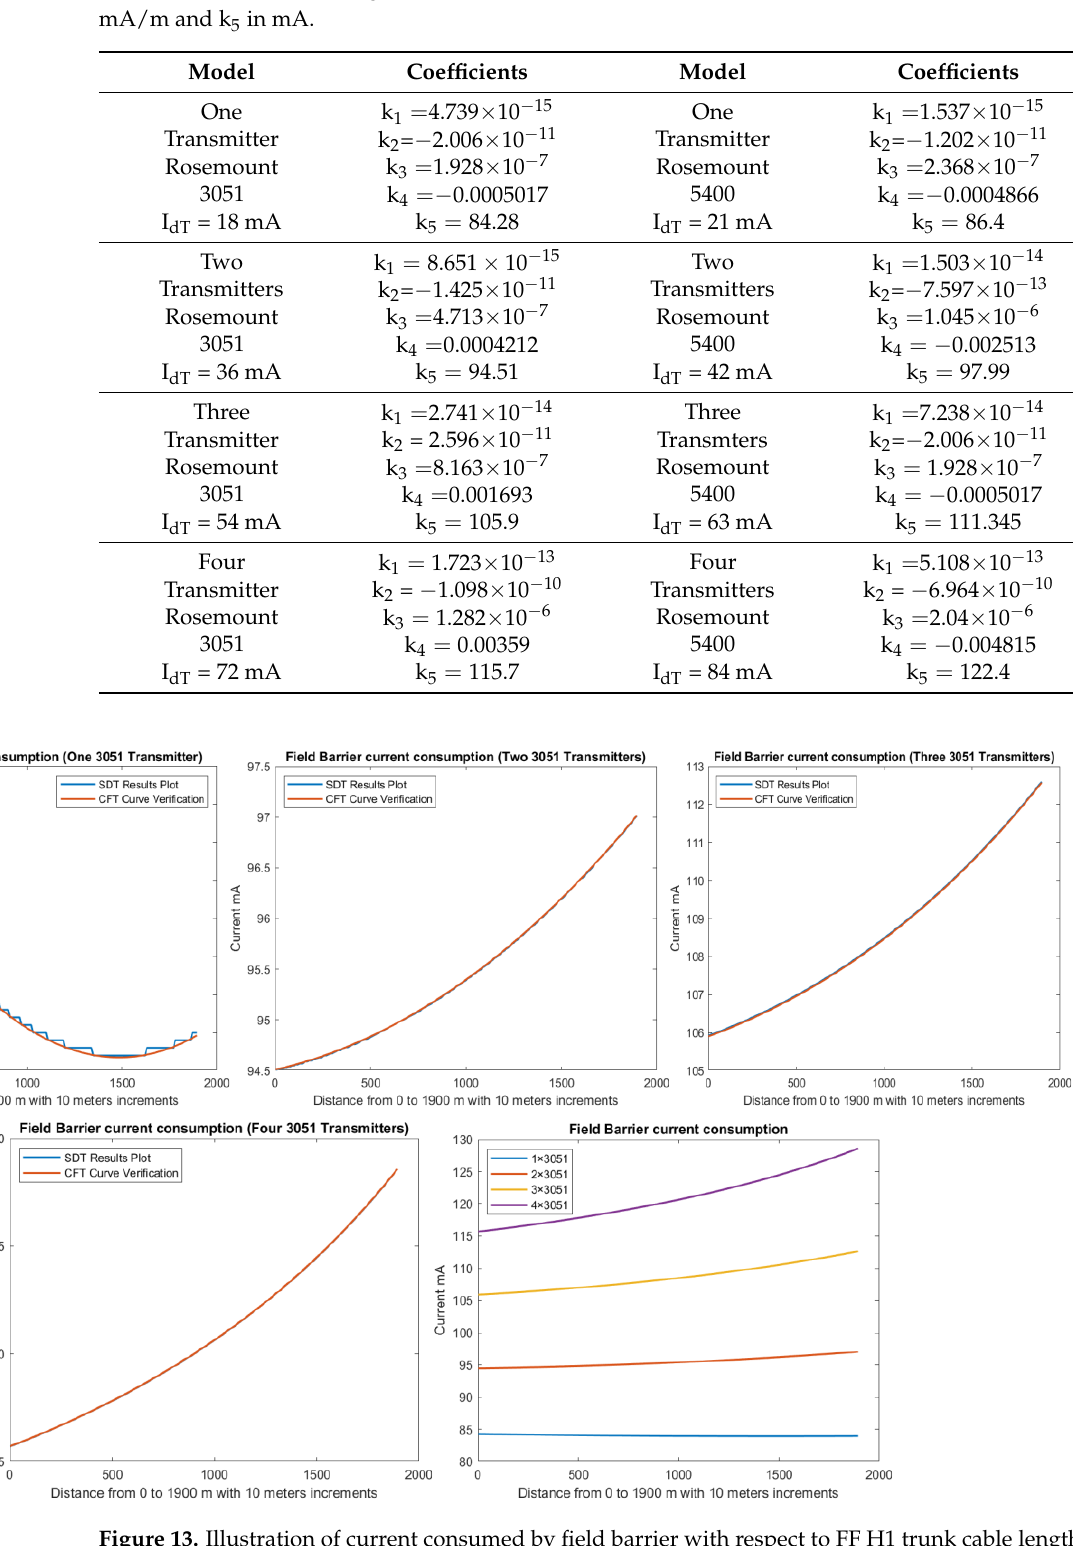
Figure 13. Illustration of current consumed by field barrier with respect to FF H1 trunk cable length when for four models in which one, two, three or four 3051 transmitters were connected to the field barriers in the models in Figure